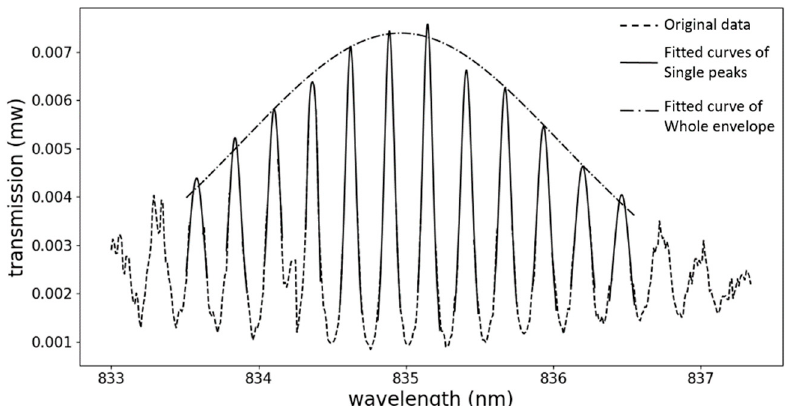
Figure 6. Illustration of the fitting procedure for the first period of the output envelope. The original data is shown, using dashed lines. The solid lines are the fitted curves of the single peaks, and the dash-dotted line is the fitted line of the whole envelope.